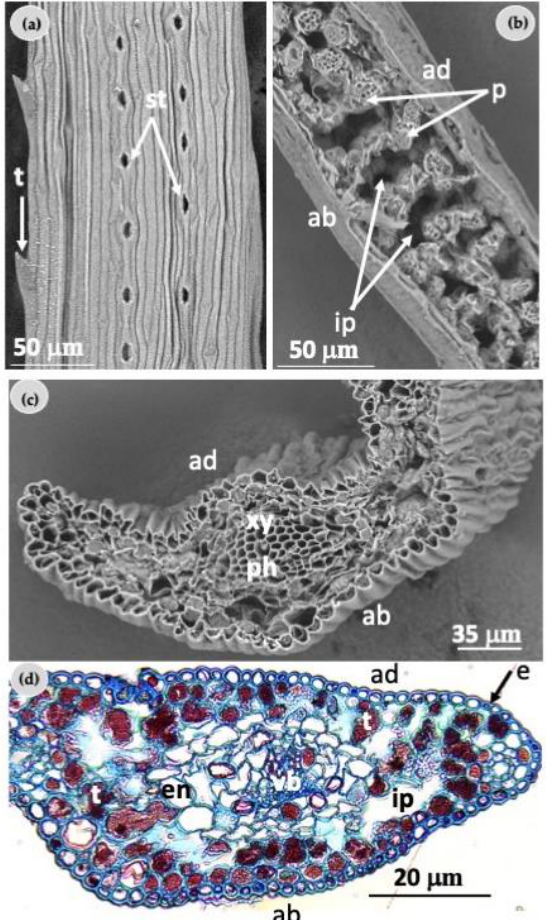
Figure 4. Scanning electron microscopy and histological observations of needles from in vitro Pinus ponderosa plantlets: ( a ) adaxial surface of a needle showing teeth (t) and two rows of stomata (st); ( b ) longitudinal section of a needle showing the parenchyma mesophyll cells (p) and the large intercellular spaces (ip) between them; ( c ) SEM observation of a needle cross section; ( d ) histological observation of needle cross section. There is poor differentiation of the vascular bundle (vb), phloem (ph), and xylem (xy) as well as of the endodermis (en). Tannin-rich cells (t) are spread among the mesophyll and large intercellular spaces (ip) are common. ab—abaxial surface; ad—adaxial surface;